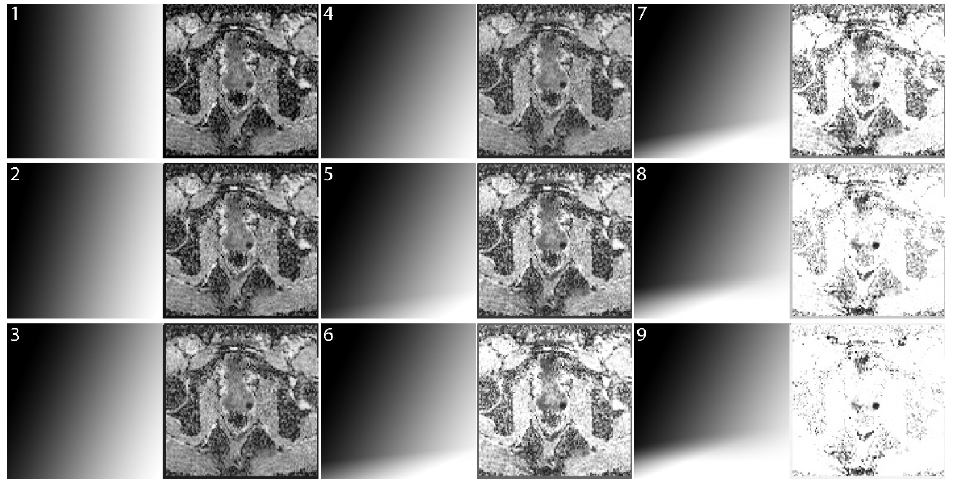
Figure 4. Increasing strengths of background suppression. Examples of different readouts from a mcDI dataset created from hbDWI and the corresponding ADC (map 1 – 9 ). The selected map is shown on the left and the resulting mcDI on the right. Map 1 has a strict vertical readout and therefore yields the original ADC image. In the following maps, the gradient is tilted clockwise in increments to include the DWI value. Additionally, another gradient is added at the bottom to suppress the background.